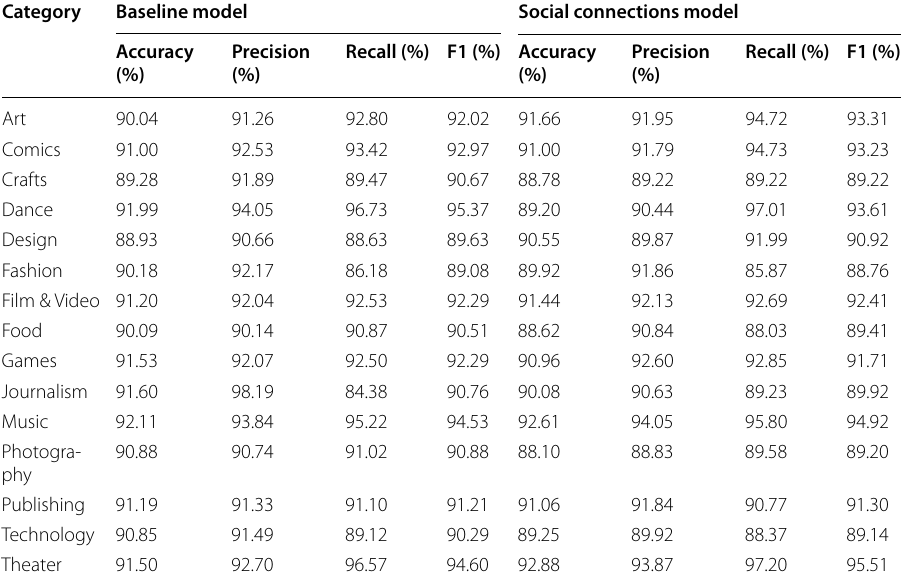
Table 9 Comparison of predictive power by category (SVM)